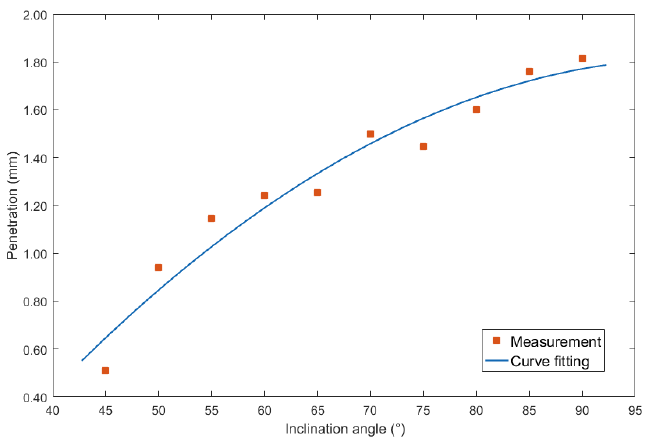
Figure 11. Curve fitting between forward inclination angle and penetration.